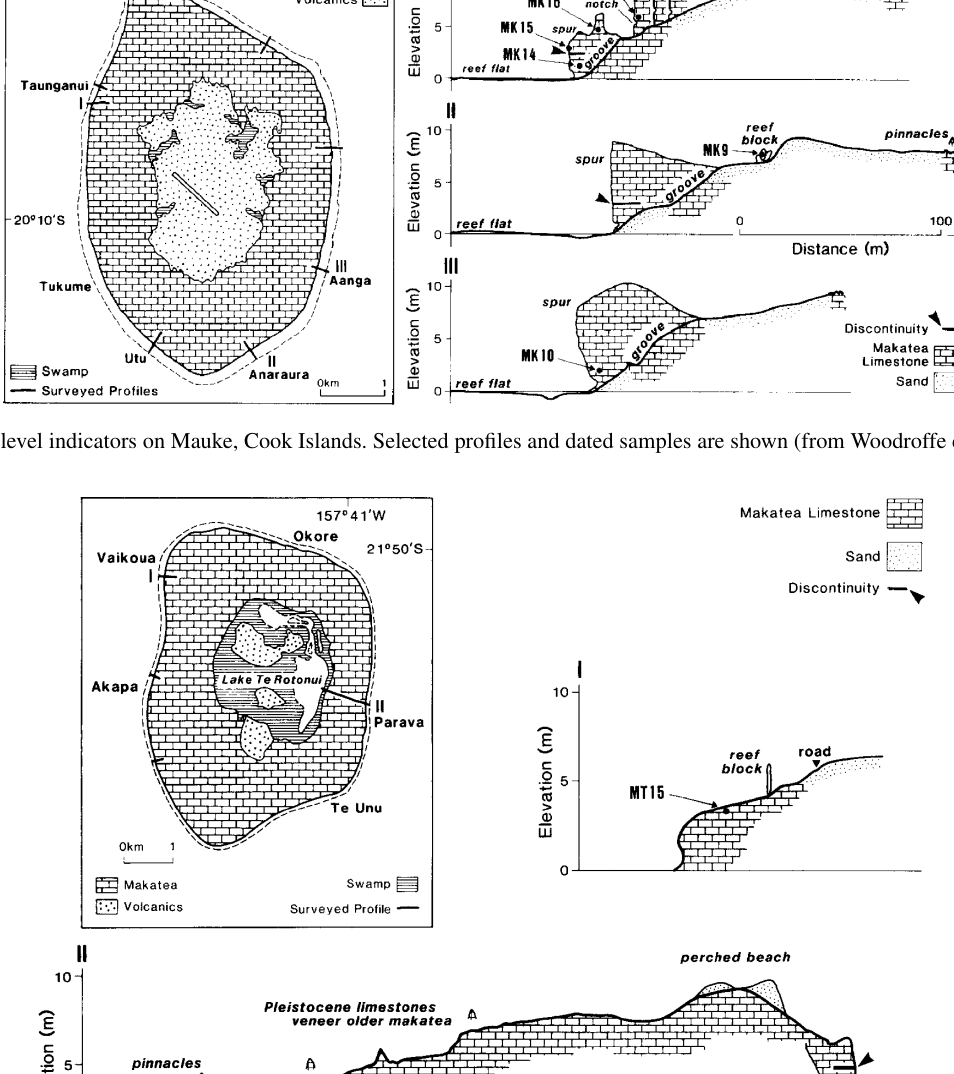
average depths of 0 and 18.5 m, respectively in modern envi-